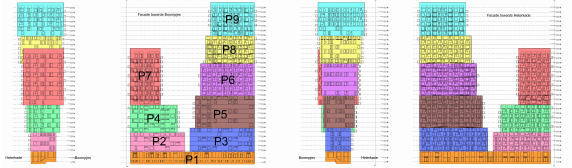
Figure 9. Segmentation of the building envelope of the actual BIM according to the horizontal